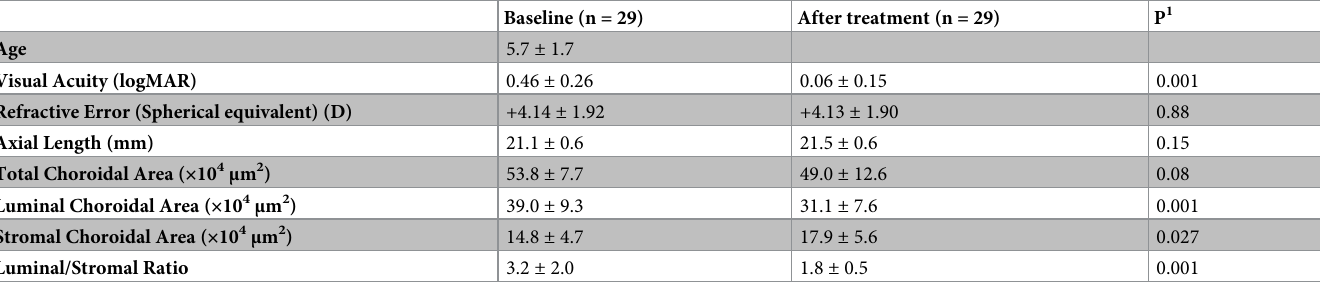
Table 1. Data of the amblyopic eye of the amblyopic patients before and after one-year optical treatment. Baseline (n = 29) After treatment (n =